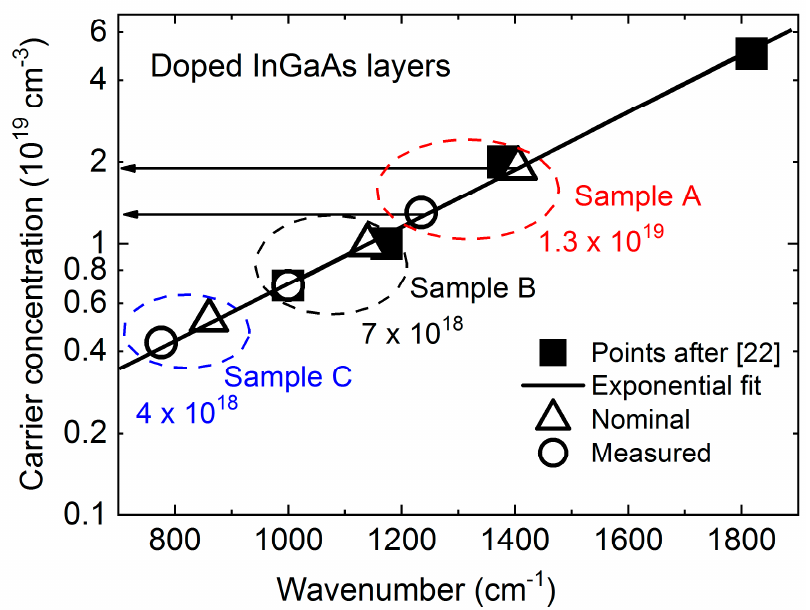
Figure 3. Carrier concentration in a function of Plasma frequency. Black squares denotes points after ref. [22] together with respective fit (red line). Triangular points represents nominal concentrations and open circles those established.